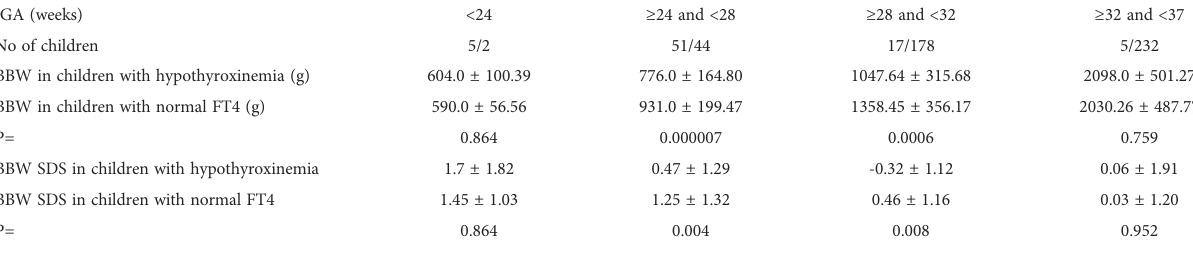
TABLE 3 Mean ( ± SD) values of body birth weight (BBW) and BBW SDS and in individual subgroups (according to GA) of children with hypothyroxinemia and those with normal FT4 concentration. GA (weeks)